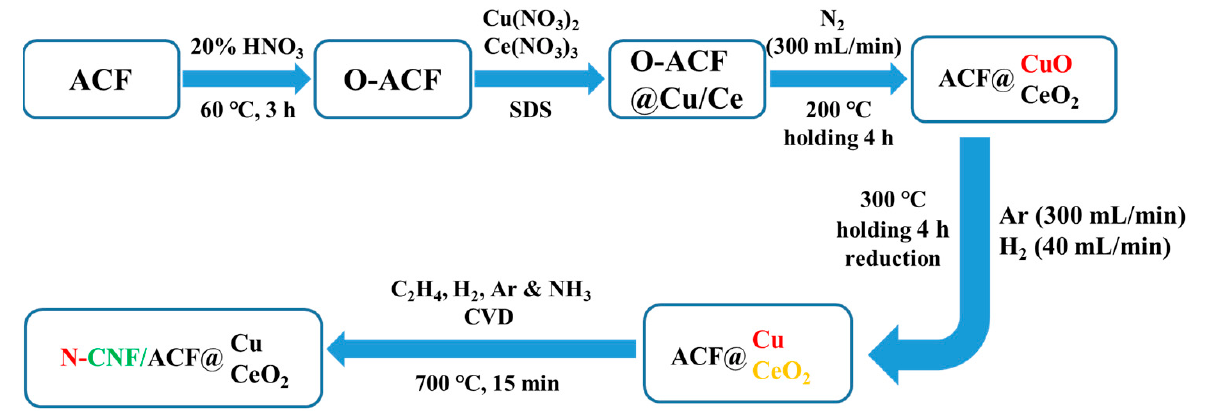
Figure 4. Preparation progress of the catalytic material.